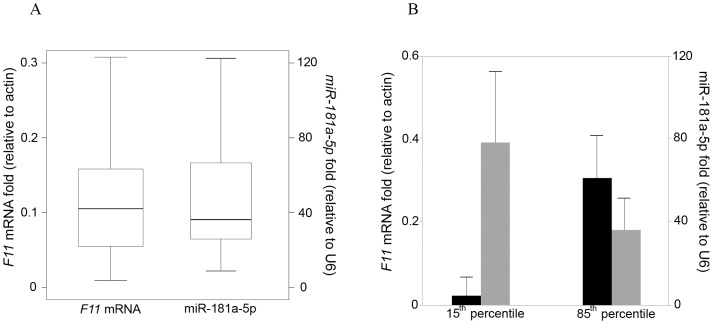
Expression range of miR-181a-5p and F11 mRNA in healthy livers.(A) Box plot of F11 mRNA and miR-181a-5p levels in livers. The upper and lower bars are the 90th and 10th percentiles, respectively. (B) Levels of miR-181a-5p (black) in livers corresponding to 15th and 85th percentiles of F11 mRNA expression (grey), mean ± SD.